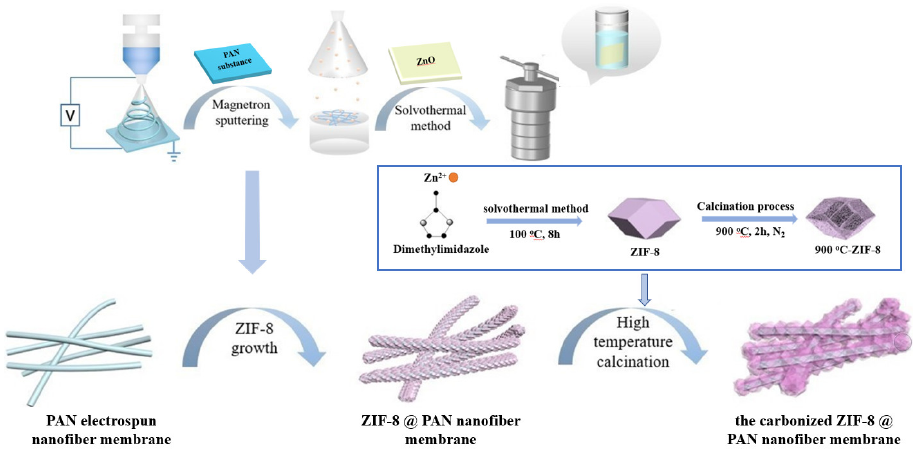
Figure 1. Fabrication route of the carbonized ZIF−8@PAN nanofiber membrane.